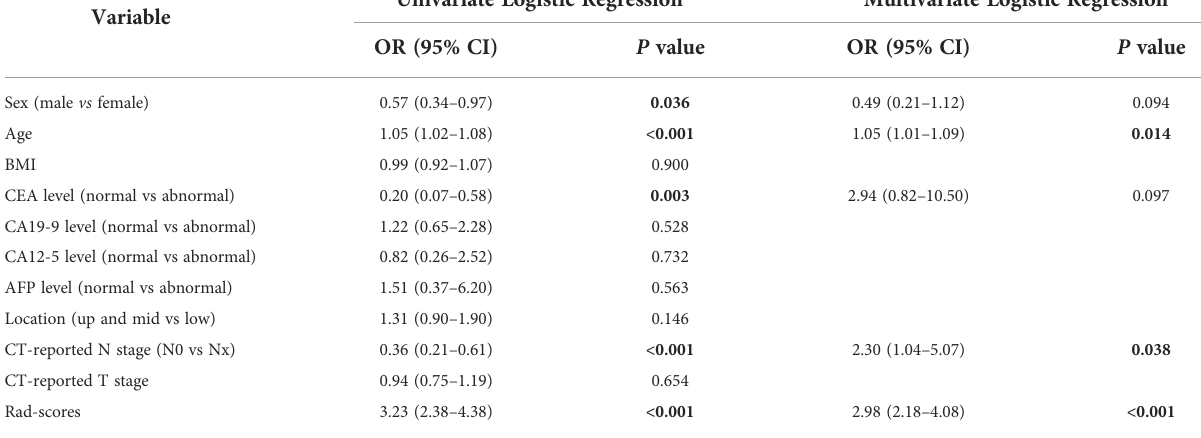
TABLE 4 Univariate and multivariate logistic regression analysis of risk factors of MMR